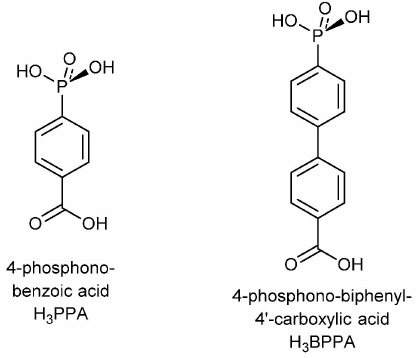
Scheme 1. Examples of phosphono-carboxylic